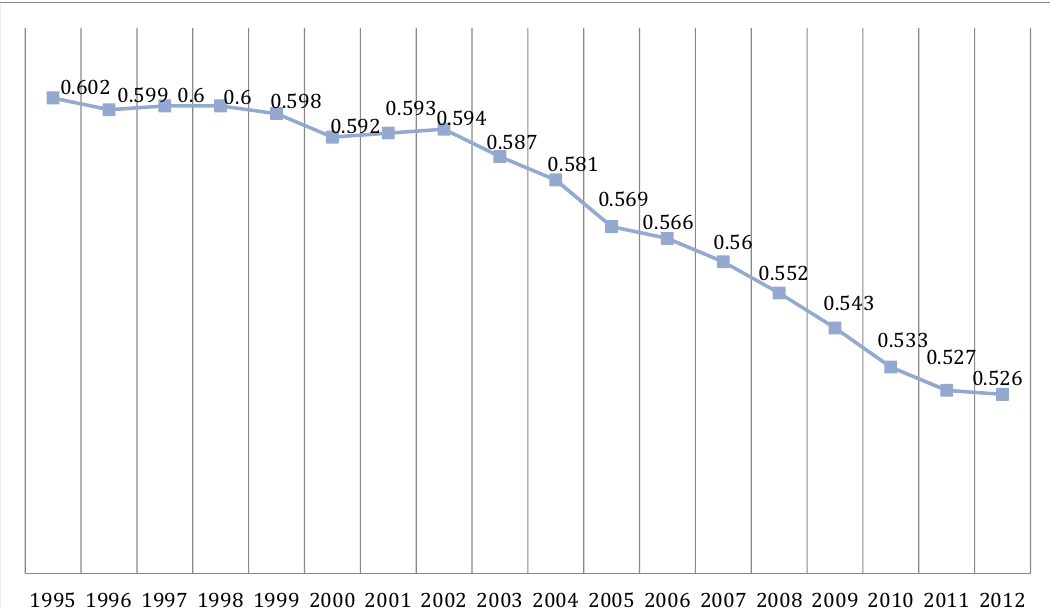
Figure 2: Movement in income inequality in Brazil (Gini index of average household income per capita), 1995 ‐ 2012 Source: